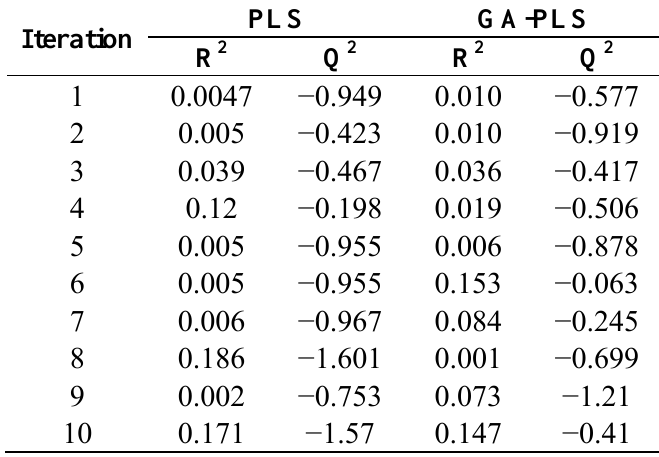
Table 9. R 2 and Q 2 values after several Y-randomization